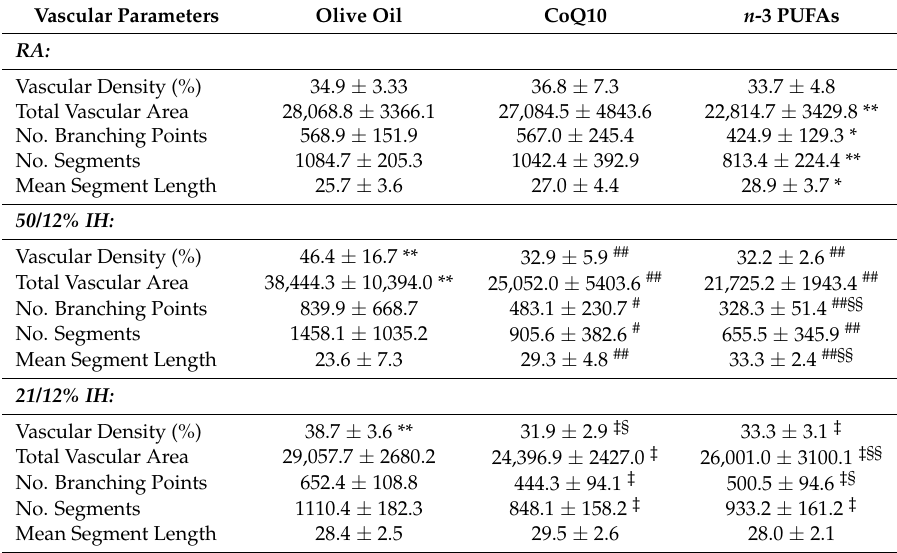
Table 4. WimRetina Quantitation of Retinal Vasculature at